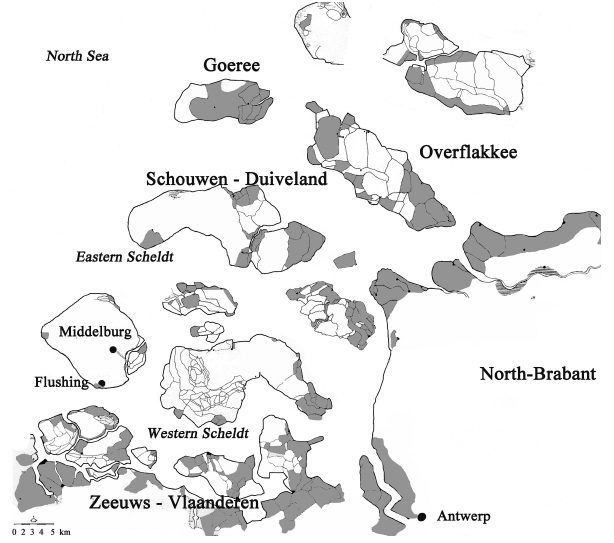
Figure 3. Reconstruction of the flooded areas (shaded) on the main islands and in the western part of North Brabant during the storm surge of 26 January 1682 (Gottschalk,